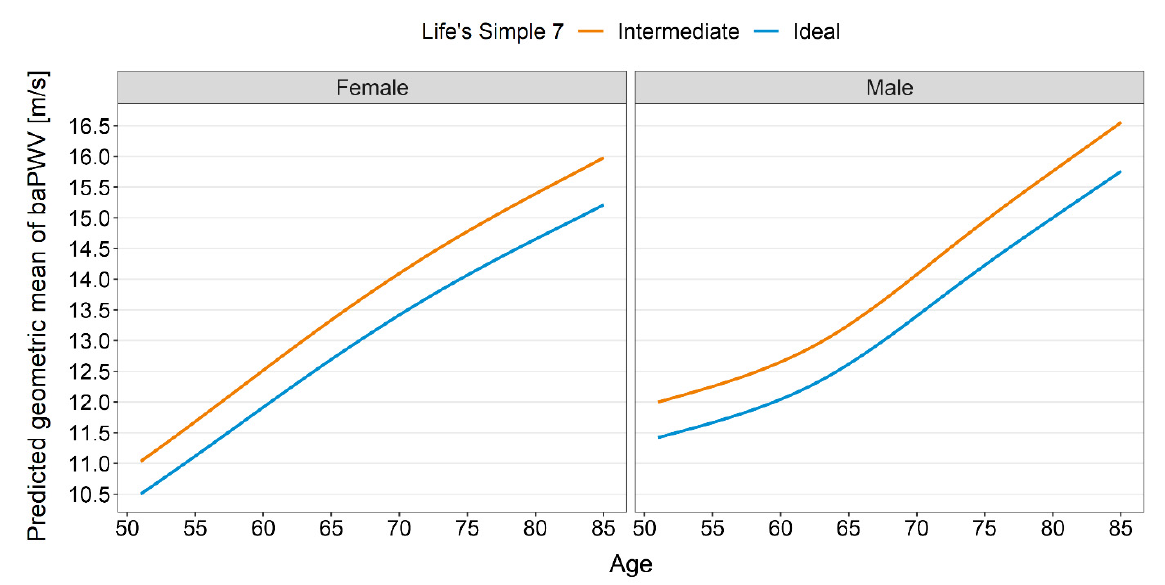
Figure 2. baPWV prediction by cardiovascular health score category. Table 2. Estimated mean difference or ratio of geometric means of the arterial properties between ideal and intermediate cardiovascular health score. Based on multiple imputation models. Adjusted for age and sex.